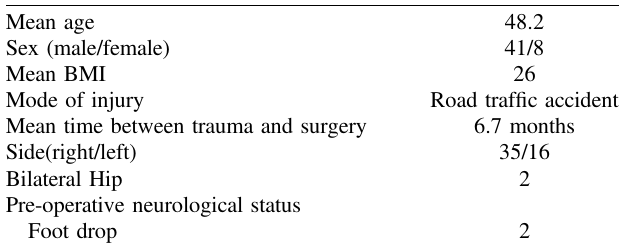
Table 1. Patient demographics ( n = 49).